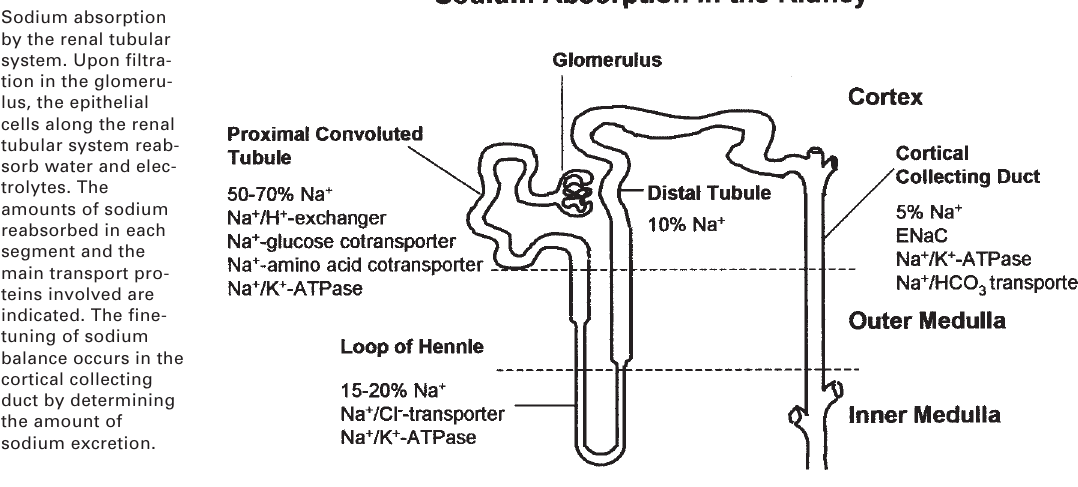
Regulation of sodium absorption by corticosteroids in the cortical collecting duct. Aldosterone binds to the MR; the re- ceptor undergoes a conformational activation, translocates into the nucleus and regulates gene transcription. Activation of MR leads to increased expression of Sgk-1, which phos- phorylates Nedd4-2. Phosphorylated Nedd4-2 no longer in- teracts with and internalises the ENaC, leading to increased expression of ENaC at the apical membrane. Activation of MR also leads to increased expression of Na + /K + -ATPase, thus causing a net increase in sodium uptake from the renal filtrate. The specificity of MR for aldosterone is provided by 11 b -HSD2 by the rapid conversion of cortisol to cortisone in renal cortical collecting duct